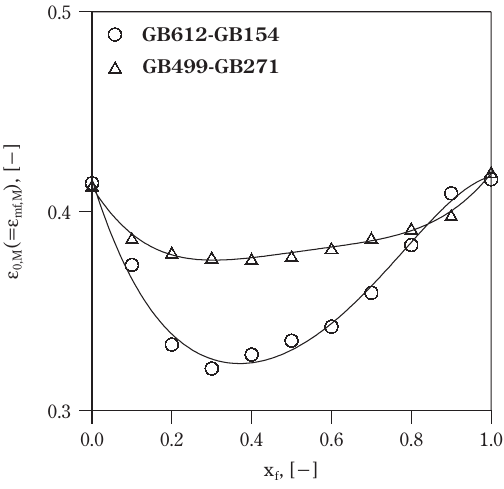
Fig. 5 Voidage of the well-mixed beds versus flotsam component average